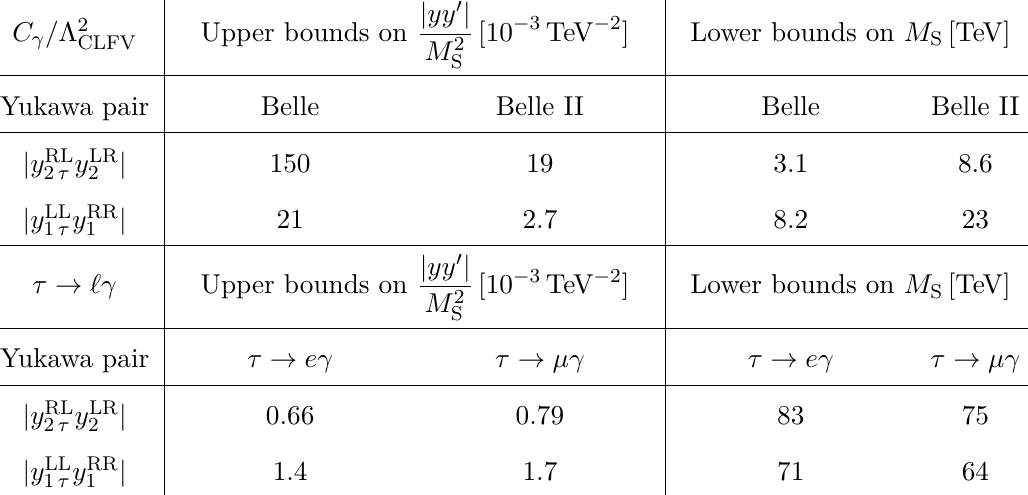
Table 5. Obtained bounds for the R 5 / 3